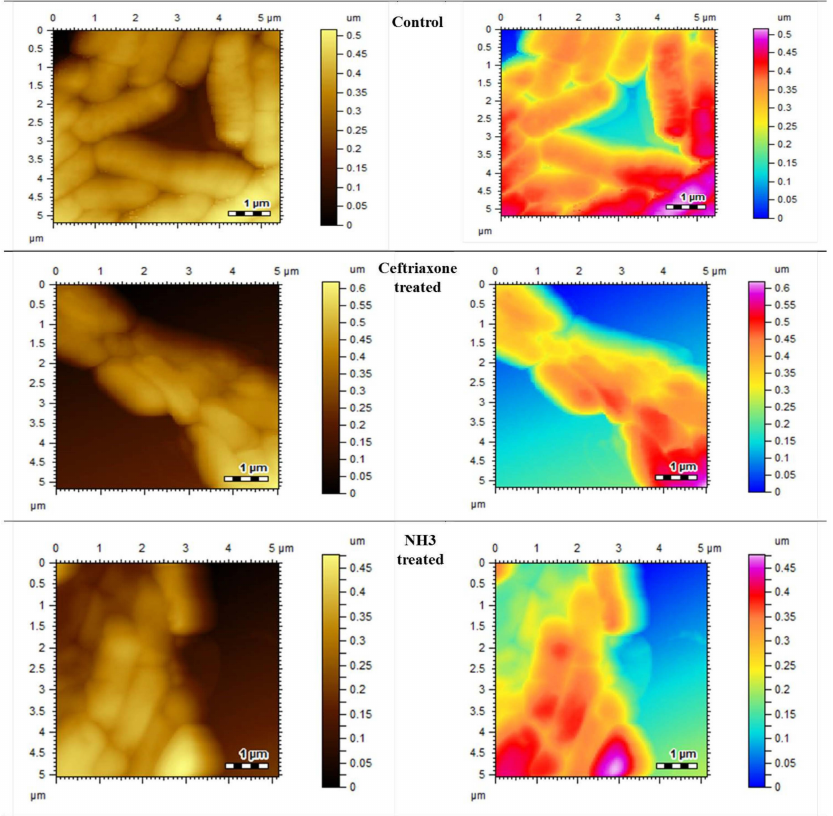
Figure 4. Atomic force microscopic images of control, standard and most effective treatment